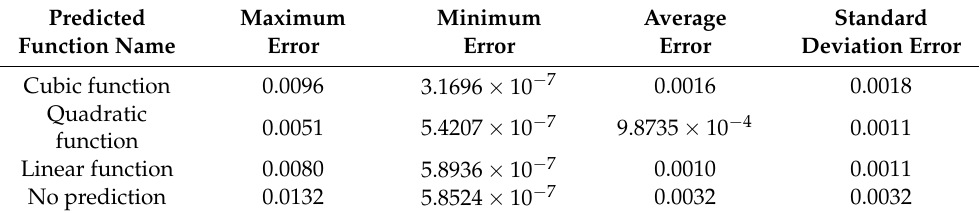
Table 1. Error comparison of cubic, quadratic, and linear function methods with no prediction